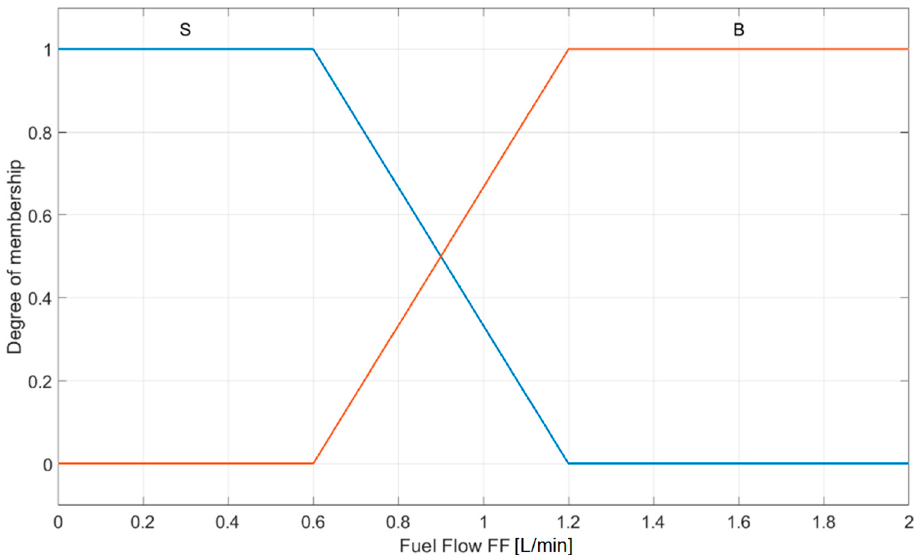
Figure 12. Fuzzy membership functions for the parameter of fuel flow. Table 1. The values of the output variables of the TSK controller.